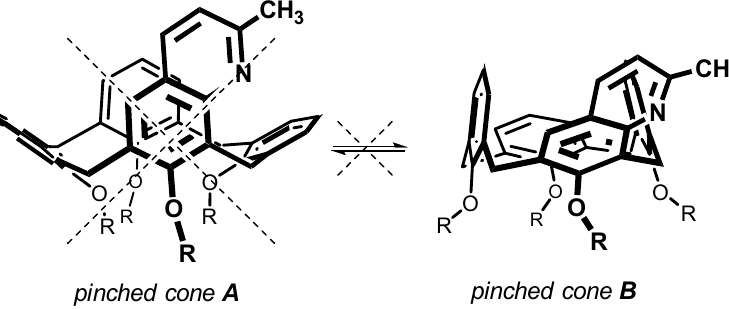
Figure 4. Pinched cone—pinched cone interconversion in calix[4]arenes (shown for compound 4a